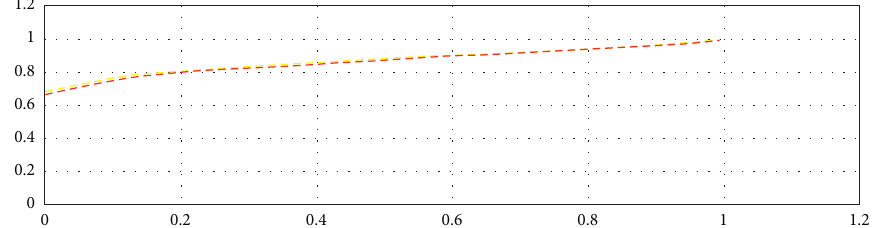
Figure 7: Comparison of the confidence level of the actual answer and the approximate solution for Example 2. Red color indicates confidence level exact solution and yellow color indicates confidence level approximate